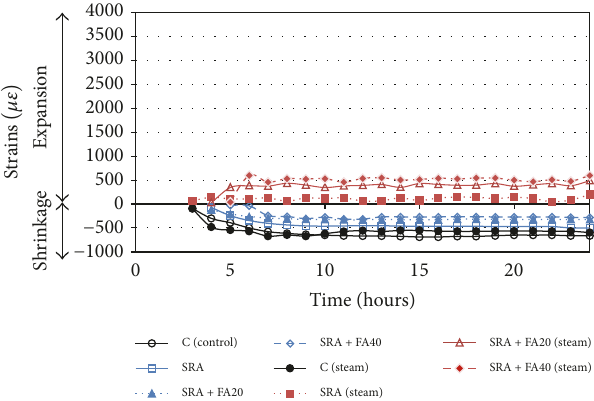
Figure 8: Early age plastic shrinkage results for EX and EX + FA.